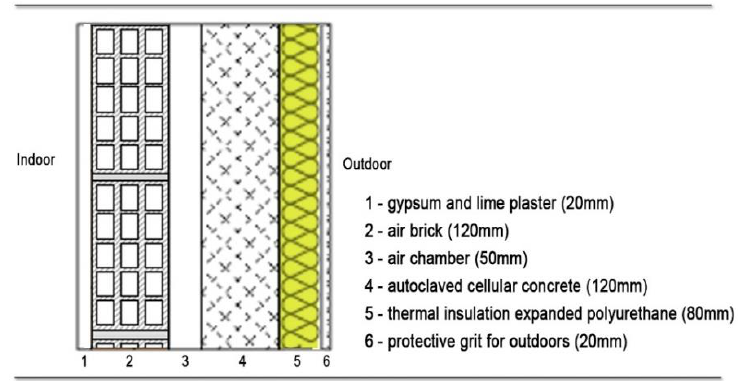
Figure 10. Wall stratigraphy with thermal insulation.